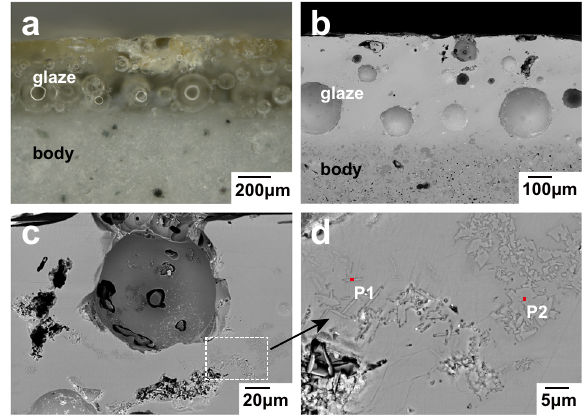
Fig. 6 OM and SEM images of sample No. 07. a and b are OM and SEM images of the polished cross section, respectively; c a bubble and a few irregular shaped holes near the surface; d short column- like crystals in the